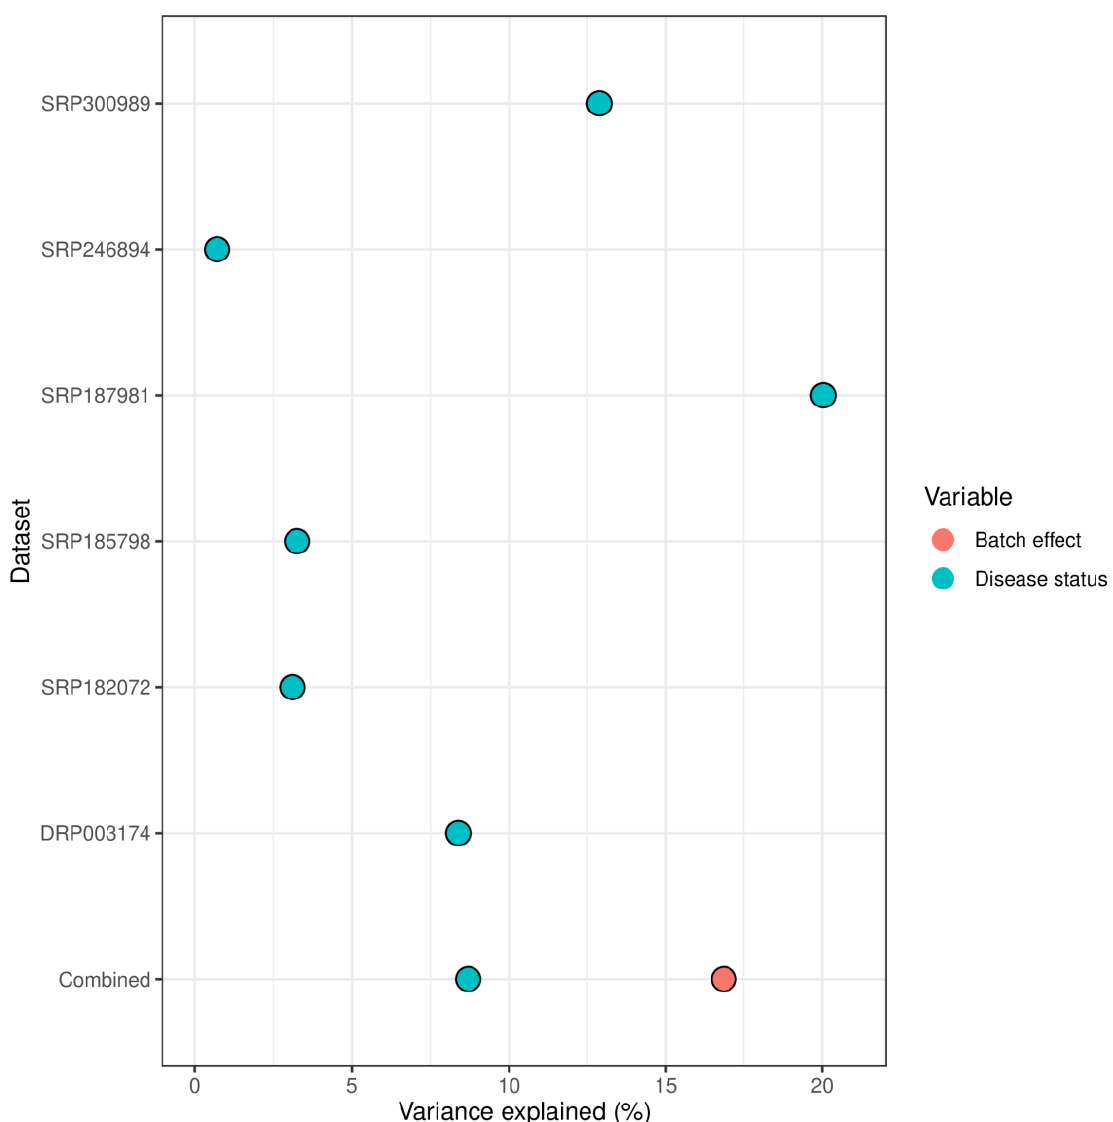
Figure 1. Microbiome variance explained by batch effect (i.e., dataset ID) and disease status (alcohol use disorder vs healthy control).